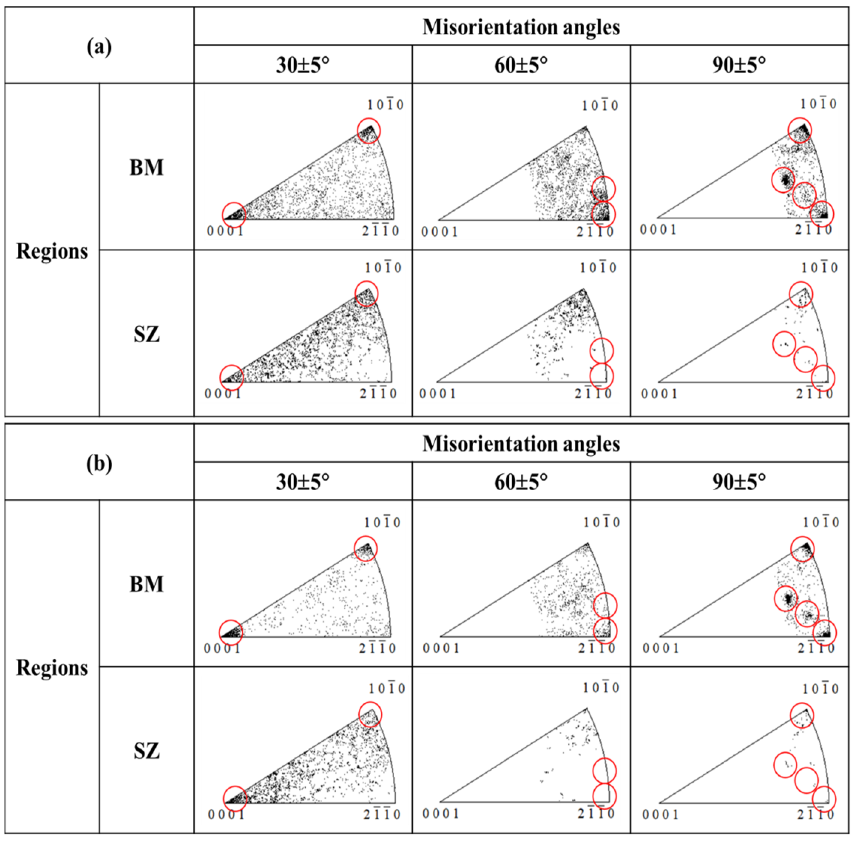
Figure 6. Misorientation angle plots sorted from BM and SZ of ( a ) fine-grained CP-Ti and ( b ) ultra- fine-grained CP-Ti. Angles of 30, 60, and 90°, which are related to TBs evaluated both in BM and SZ.